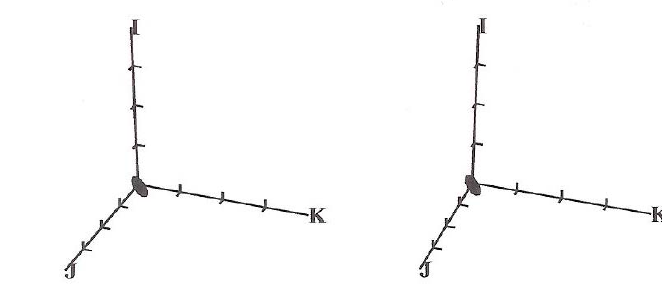
Figure 1: Stereo-pair scatter plot of fifty measurements of refractive state taken from a test eye. The origin is at the mean of the data and the axis length is one dioptre. By converging to a point in front of the page the reader will be able to fuse the two halves of the scatter plot and be able to appreciate a three dimensional percept of the figure (this applies to all scatter plots in this